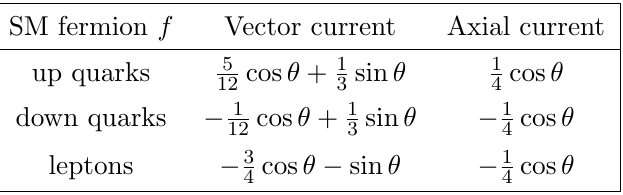
Table 2 . Coe(cid:14)cients of the vector and axial vector bilinear currents for the SM fermions f (in four component notation). The coe(cid:14)cients c V (vector) and c A (axial) are obtained from the coe(cid:14)cients of the left handed ( c L ) and right handed ( c R ) fermions in the SM via c L P L + c R P R = c L + c R + (cid:0) c L + c R (cid:13) 5 ) c V = c L + c R 2 2